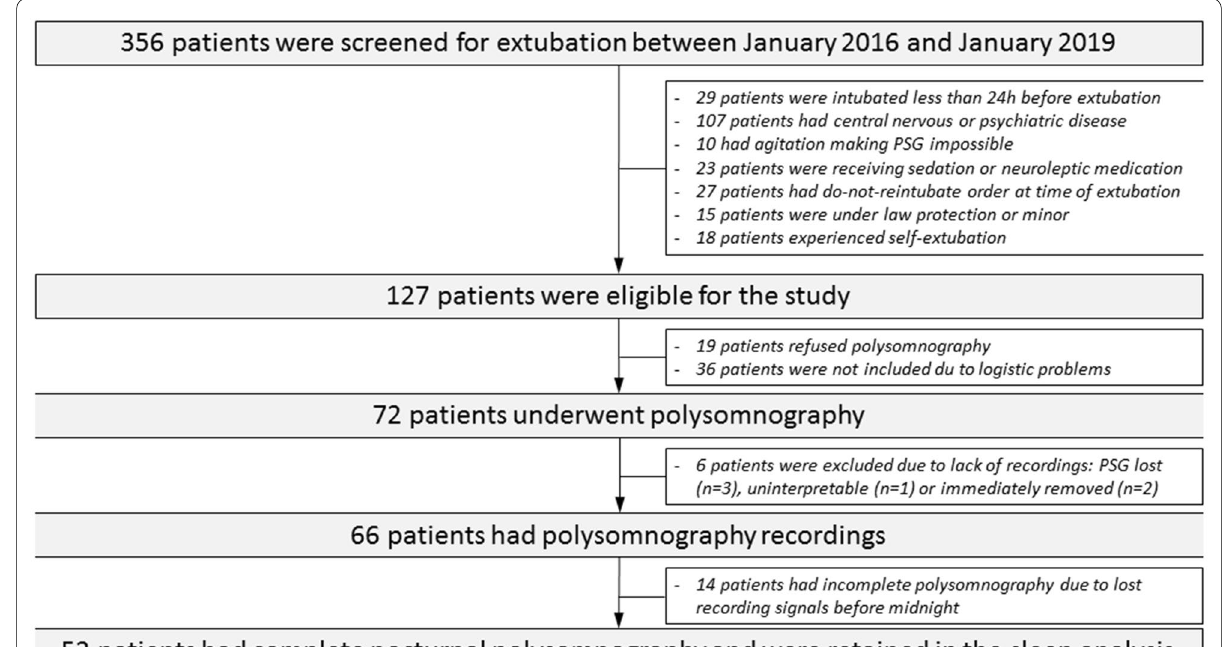
Fig. 1 Flowchart of the